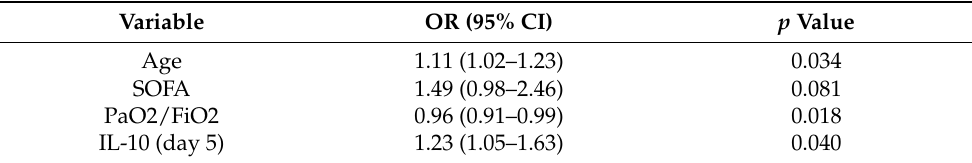
Values in parentheses are 95 per cent confidence intervals, Variables with p < 0.10 in univariate analysis were entered into multivariable models, Area under receiver operating characteristic curve (AUROC 0.92), Hosmer– Lemeshow (HL) χ 2 = 15.74, p =